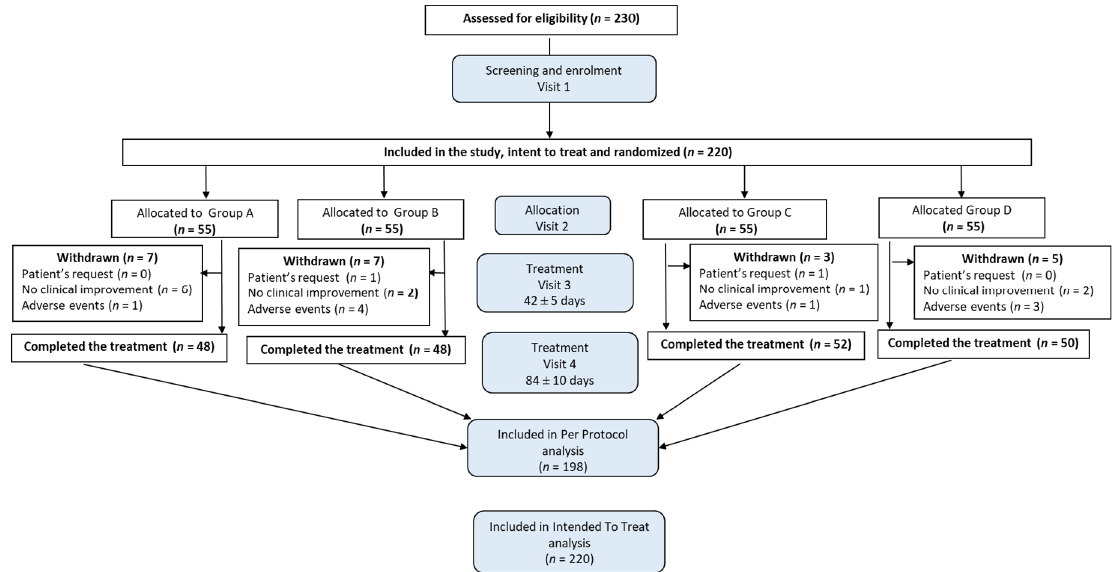
Figure 1. CONSORT flow chart of the disposition of patients in four arms of the study, from Visit 1 to